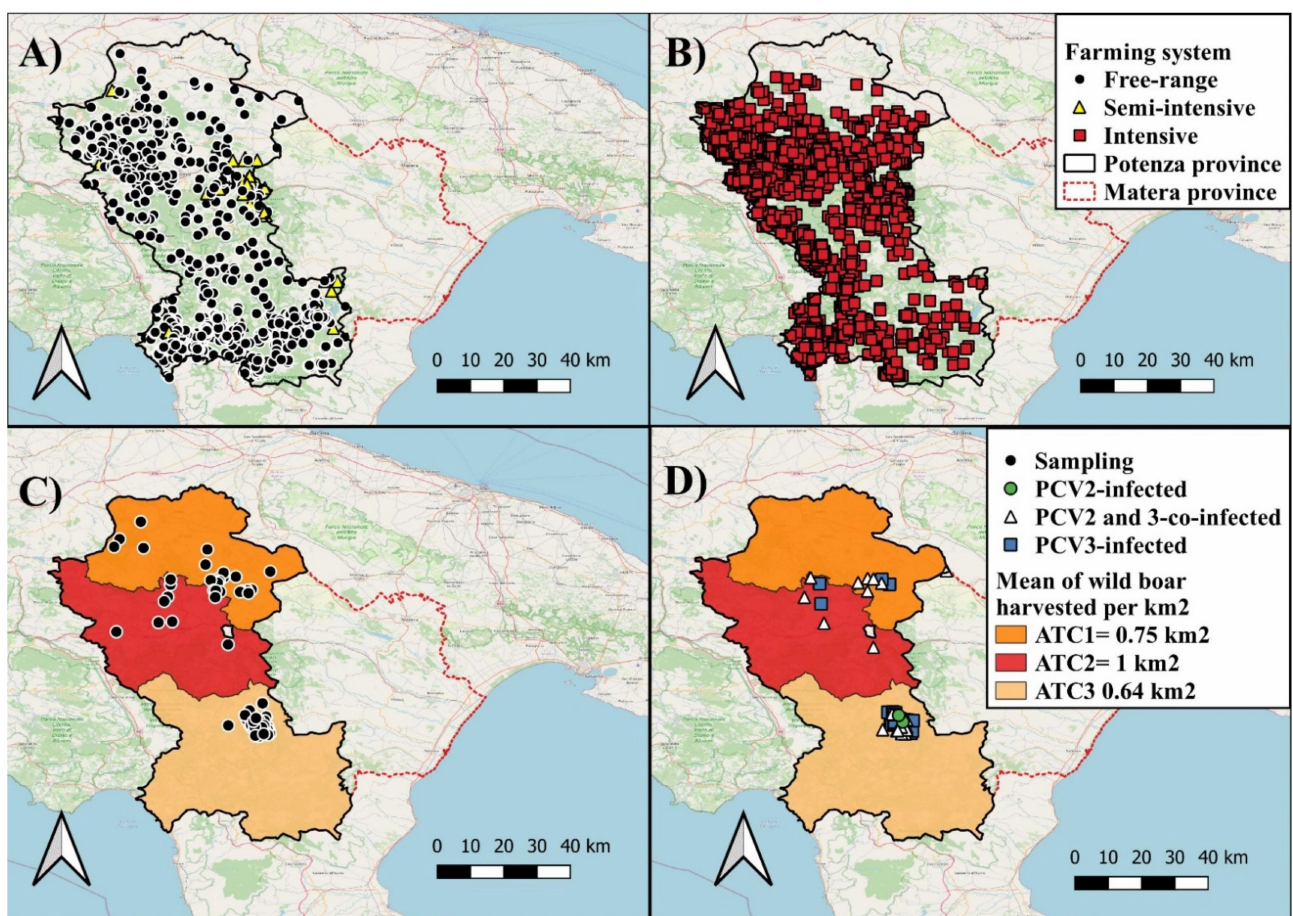
Figure 1. Map of Basilicata region showing distribution of semi-intensive and free-range pig farms ( A ) and intensive pig farms ( B ). Distribution of collected samples ( C ) and of PCV2-positive, PCV3- positive and PCV-2/PCV3-co-infected wild boar in different hunting districts (Ambiti territoriali di Caccia, ATC) ( D ). The choropleth map ( C , D ) shows the wild boar density per ATC, computed as the mean of wild boar harvested from 2015/2016 to 2019/2020 hunting